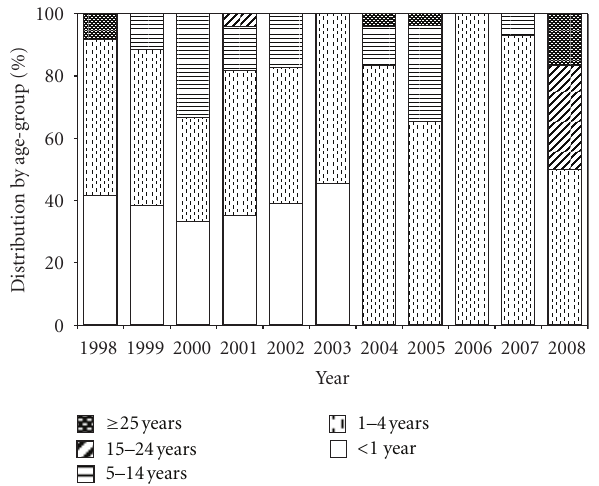
Figure 4: Age distribution of notified pertussis cases in Greece by year (1998–2008).